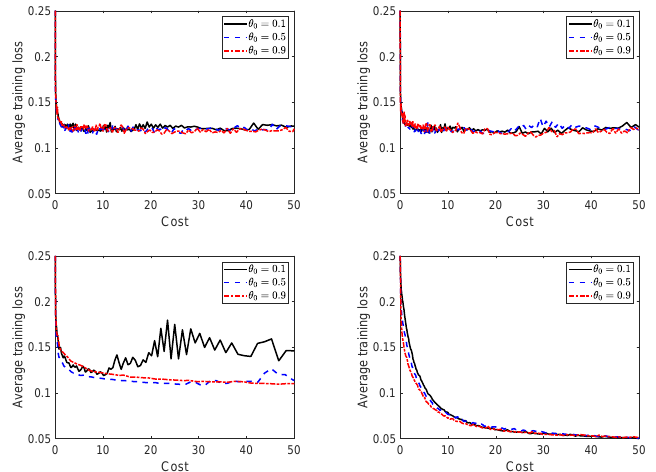
Figure 3. Average training loss versus average computational cost of SIRTR p equipped with different values for the initial penalty parameter θ 0 . Top row : a8a ( left ) and a9a ( right ). Bottom row : mnist ( left ) and phishing ( right ).